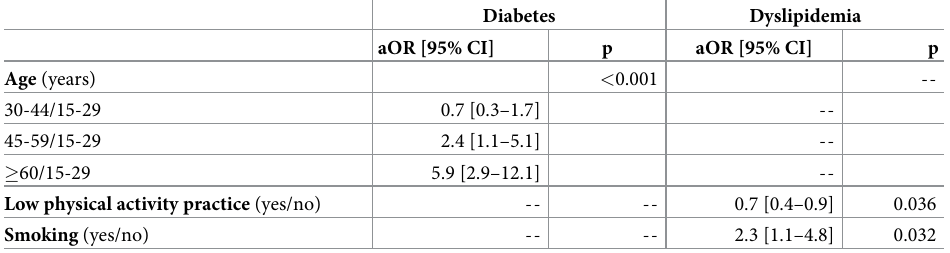
Table 4. Factors associated with self-reported diabetes mellitus and dyslipidemia, multivariable analysis, Parakou 2016.